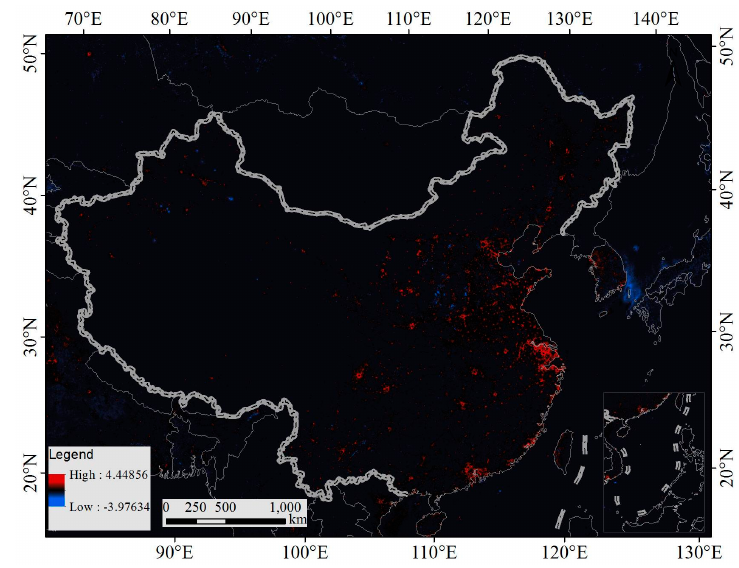
Figure 5. Change trend of nighttime light pollution in China (red color represents a light pollution increase, blue color represents a light pollution decrease, and black color represents stable light pollution).